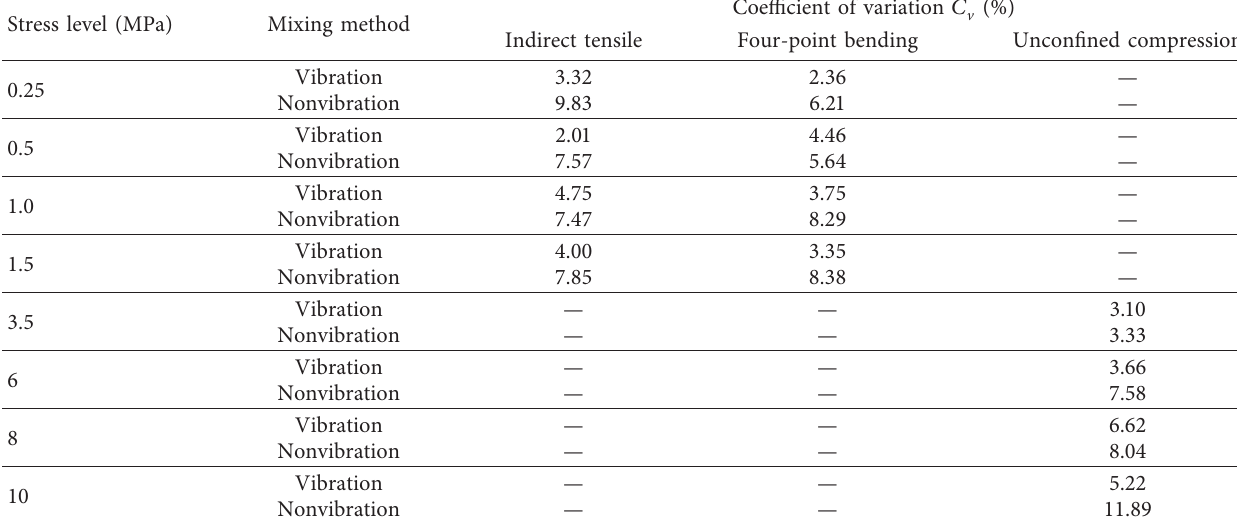
Table 6: Coefficient of variation of the modulus test results of specimens prepared by vibratory and nonvibratory mixing. Stress level